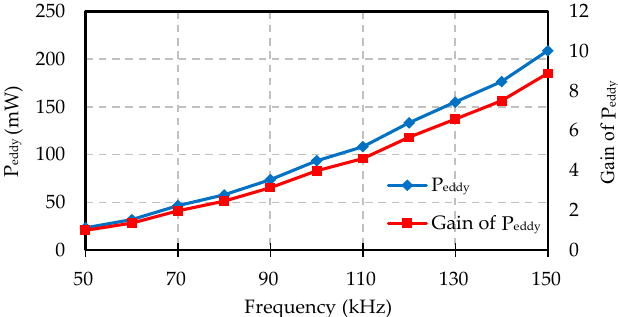
Figure 3. The eddy current loss variation with frequency. The blue line represents the eddy current loss at each frequency, the red line repre- sents the ratio of eddy current loss at each frequency to that at 50 kHz. It can be seen from Figure 3 that the eddy current loss increases sharply with the increasing frequency, therefore, eddy current loss is a non-negligible factor for underwater WPT system. In order to make a direct equivalent to the influence of the eddy current loss in the circuit, the eddy current loss P eddy can be divided into the sum of the eddy current loss P eddy_p generated by the transmitting coil and the eddy current loss P eddy_S generated by the re- ceiving coil. When the unilateral coil is excited by the current, the eddy current loss in the seawater divided by the square of the current is a fixed value. The equivalent eddy current resistances on the transmitting coil and receiving coil can be expressed as: The eddy current loss of the transmitting coil and the receiving coil as well as the corresponding equivalent eddy current resistance simulation results are shown in Figure 4. It can be seen from Figure 4 that the eddy current loss increases significantly with the increase in the coil current, so it is necessary to consider the influence of the eddy current loss on the system in the seawater condition. The ratio of the eddy current loss generated by the unilateral coil to the square of the coil current is a fixed value, the transmitting coil is 30 m Ω , and the receiving coil is 8 m Ω . Accordingly, the influence of eddy current loss can be considered into the system, and when the operating frequency is determined, the equivalent eddy current resistance is a fixed value, which is an inherent parameter decoupled from the operating state of the system. Figure 4. Simulated the eddy current loss caused by different excitation currents. ( a ) Generated the eddy current loss in seawater by the transmitting coil; ( b ) Generated the eddy current loss in seawater by the receiving coil.